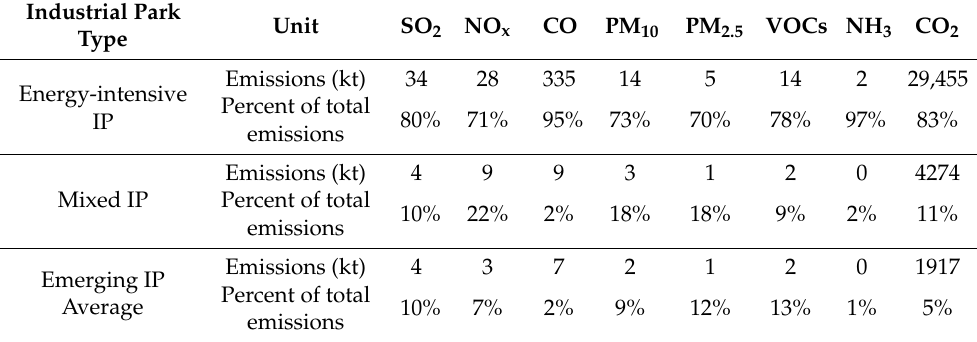
Table 2. Emissions of three type of